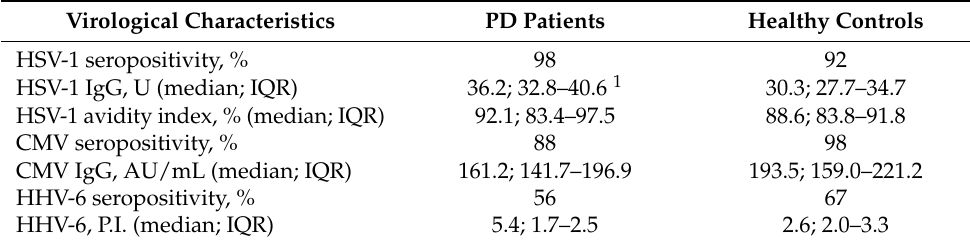
Figure 1. Distribution of serum HSV-1-specific IgG titers in Parkinson’s Disease patients and Healthy Controls. Horizontal lines represent the median. PD: Parkinson’s Disease; HC: Healthy Controls; U: units. Table 2. Virological characteristics of the individuals enrolled in the